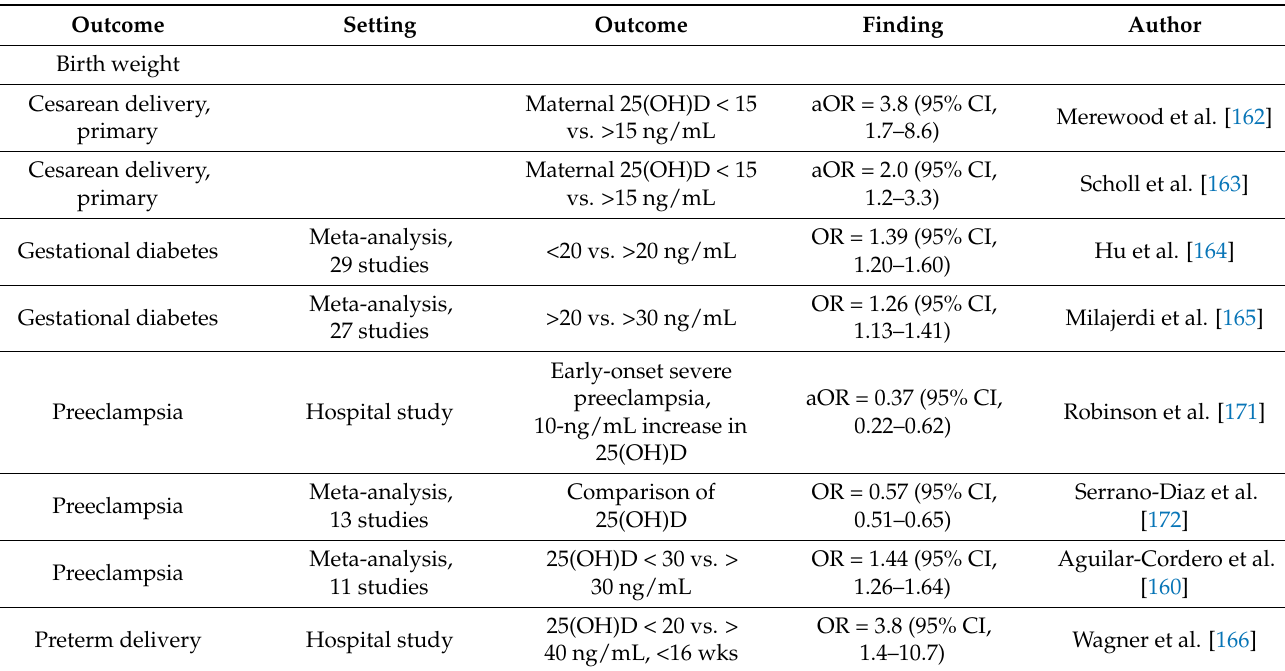
Table 4. Representative pregnancy and infant outcomes with respect to maternal serum 25(OH)D concentration in observational